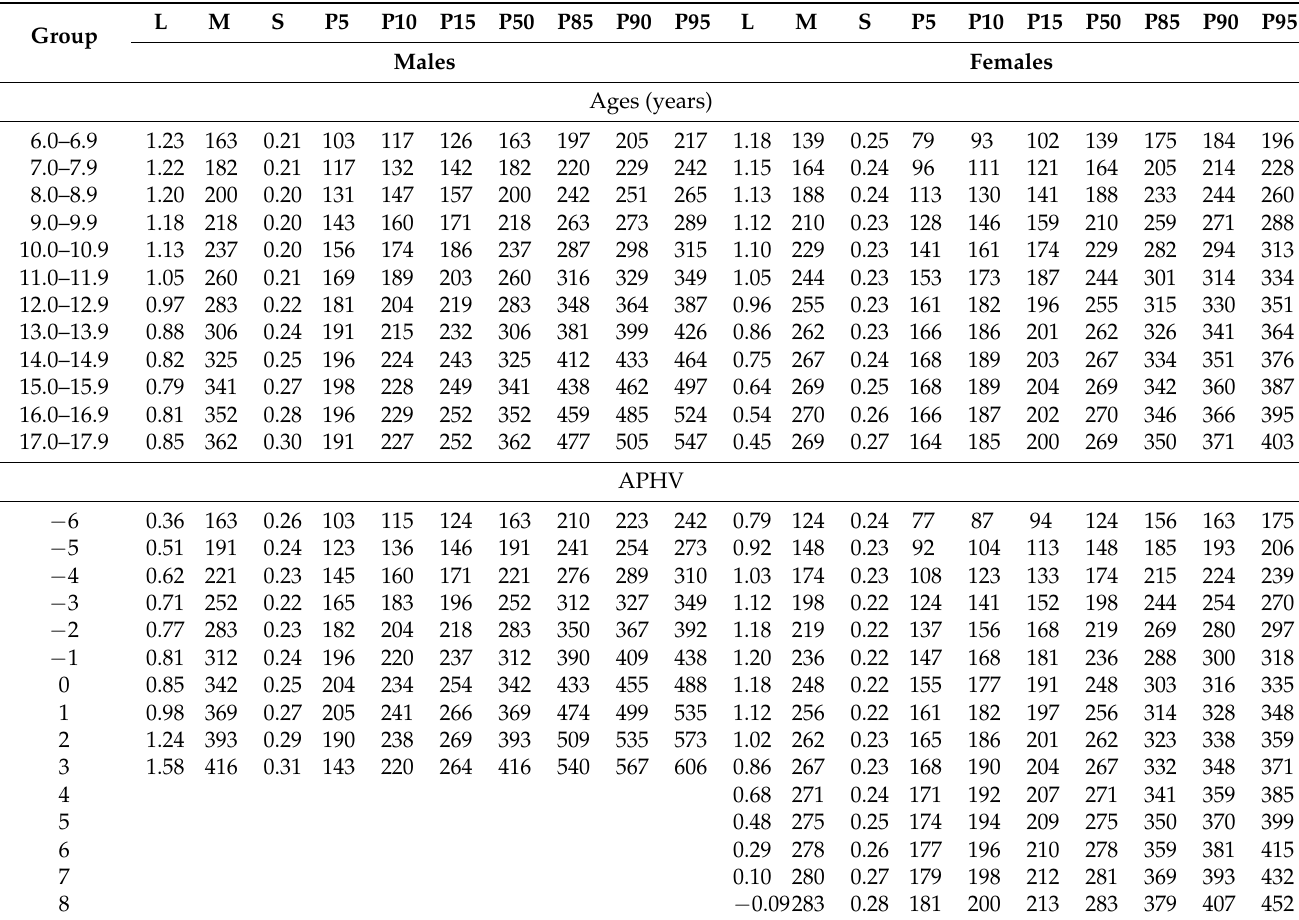
Table 2. MEF percentiles (L/min) based on chronological age and maturity (APHV) for both sexes.